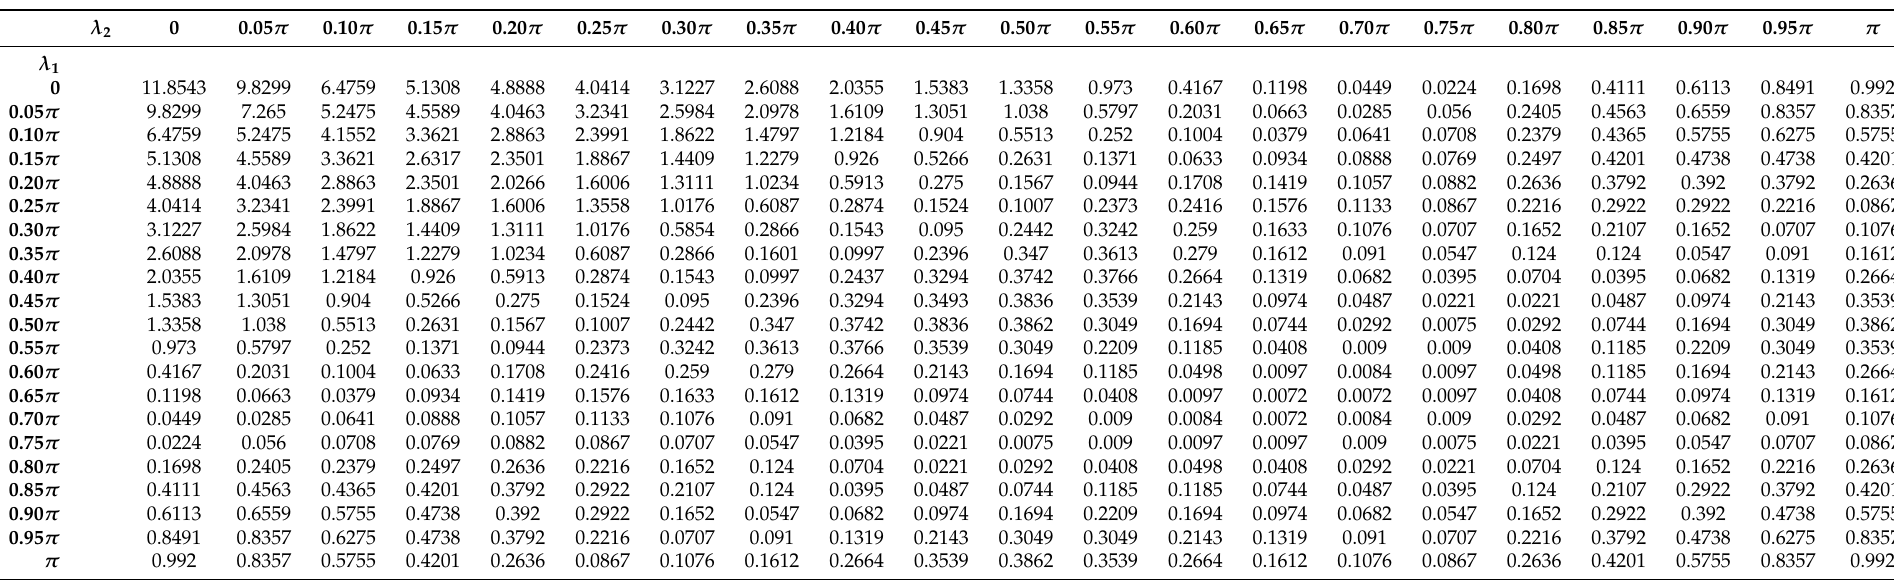
Table 3. Numerical values of smoothed multitapered biperiodogram of DCGINAR(1) model with M = 13 and β =